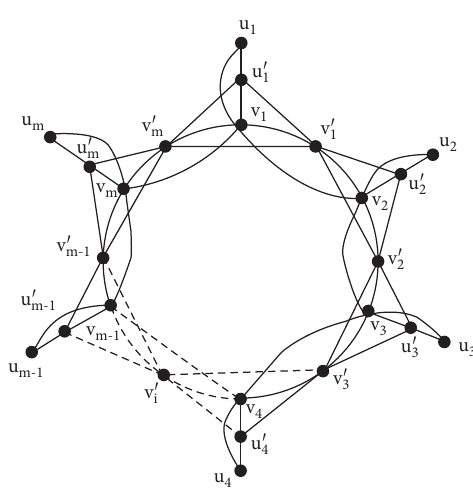
Figure 3: Total sunlet network TS